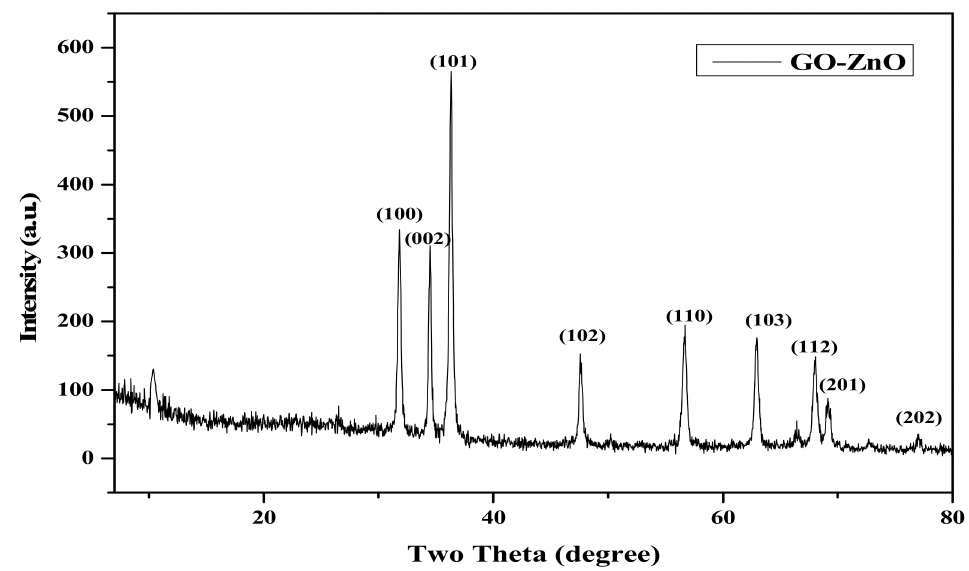
Figure 1. X-ray diffraction (XRD) structure of nanocomposites.